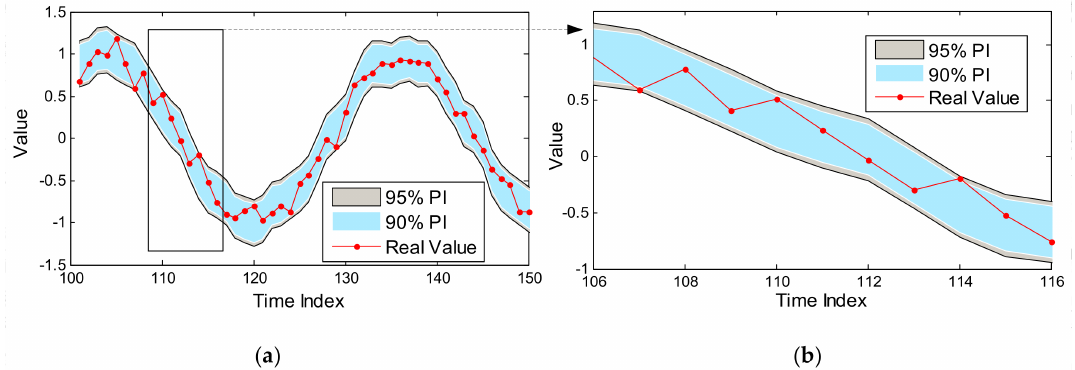
Figure 3. One prediction example for sine function with noise based on GPR model. ( a ) The whole prediction result; ( b ) The enlarged curve at the index from 106 to